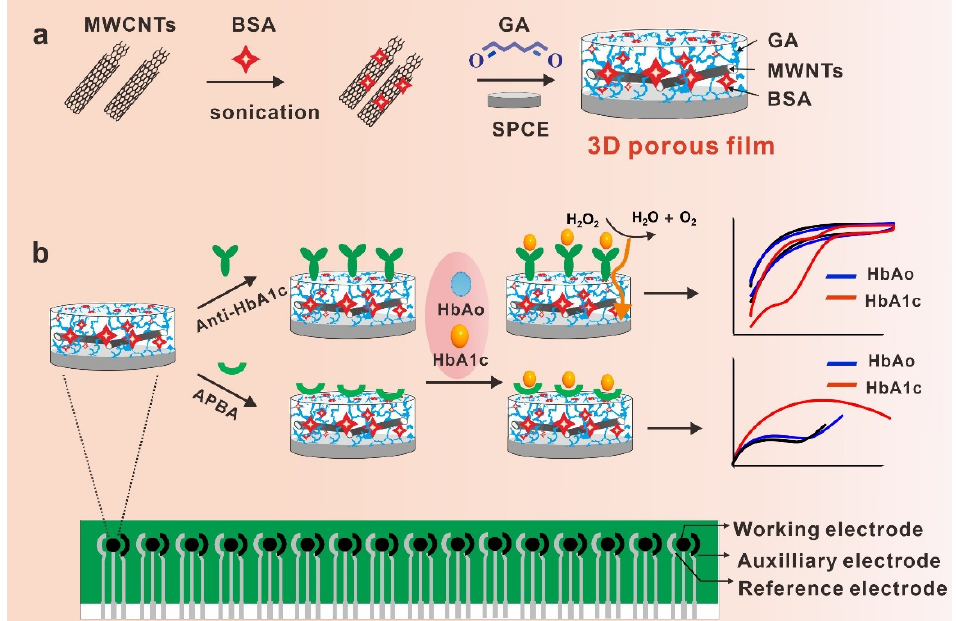
Scheme 1. ( a ) Schematic illustration of the bovine serum albumin and multi-walled carbon nanotubes cross-linked with glutaraldehyde (BSA/MWCNTs/GA) layer on the surface of the screen-printed carbon electrodes (SPCE); ( b ) schematic illustration of the BSA/MWCNTs/GA-coated electrodes functionalized with different bioprobes for selective sensing of